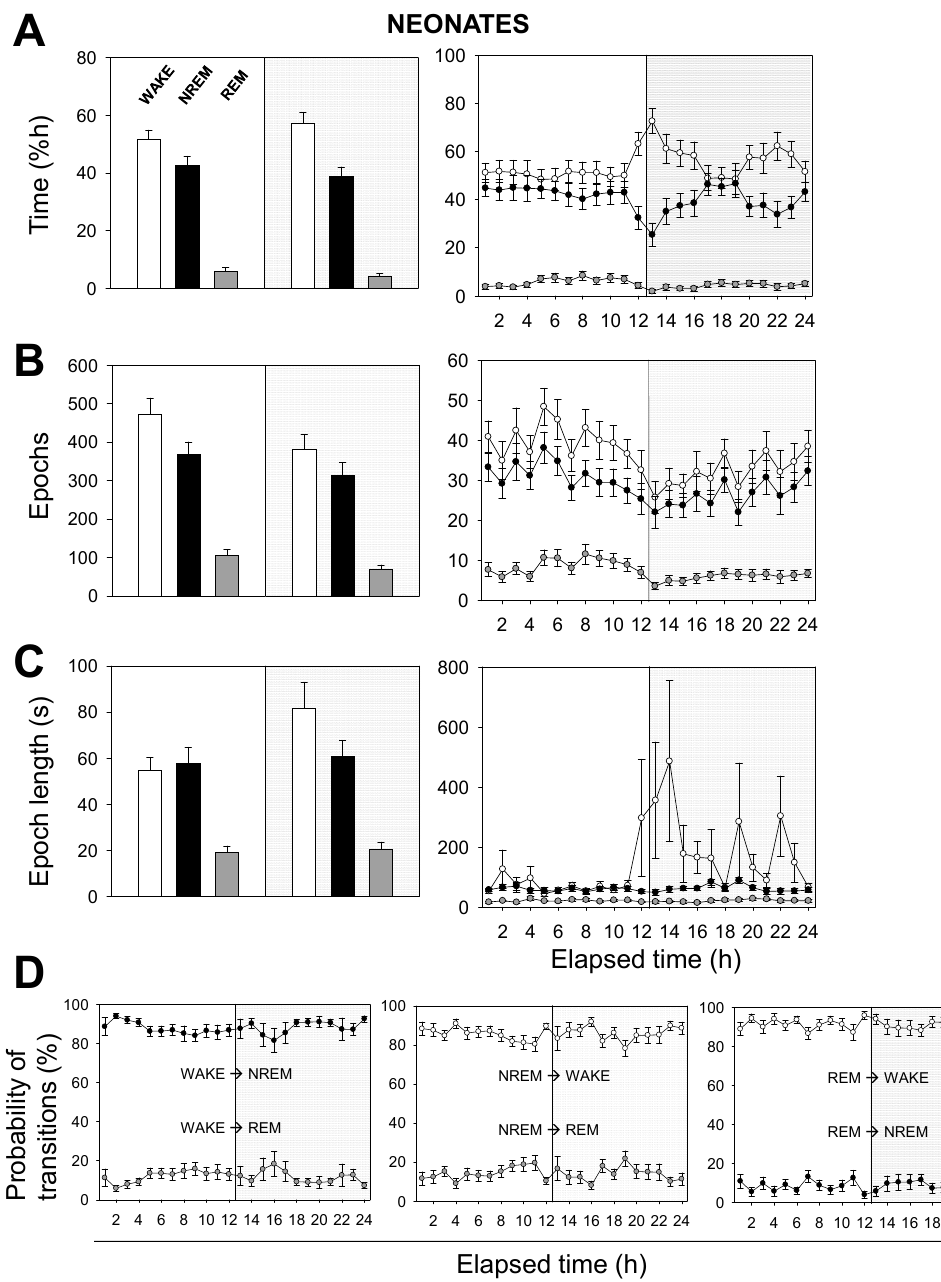
Figure 2. Sleep–wake characterization in neonatal mice. ( A ) Percentage of time spent, ( B ) total number of epochs, and ( C ) epoch length. White, black, or gray bars represent wakefulness, NREM, or REM sleep states, respectively. Parameters in ( A – C ) are calculated during a total of 12 h-light (white background) or 12 h-dark (gray background) phases (left panels) or across the recording time within the 24 h period (right panels). ( D ) Probability of behavioral state transitions for every hour during the recording session (1–24 h.). Left panel: From wakefulness into NREM and REM sleep. Middle panel: From NREM sleep into wakefulness and REM sleep. Right panel: From REM sleep into wakefulness and NREM sleep. White, black, or gray circles represent wakefulness, NREM, or REM sleep states, respectively. Data shown as mean ± SEM of 18 recordings retrieved from 6 neonatal mice.